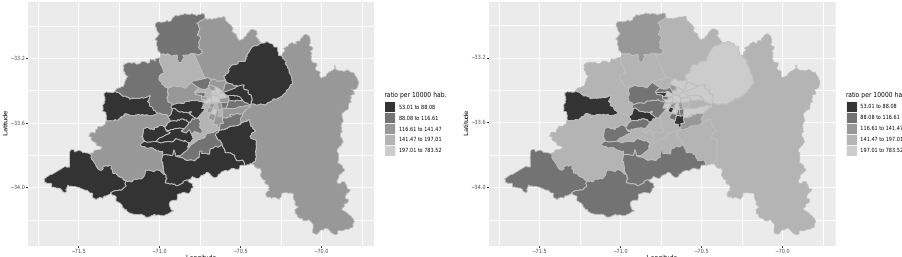
Figure 1. Average annual ratio of crimes against people ( left ) and crimes against property ( right ) (2010–2018).